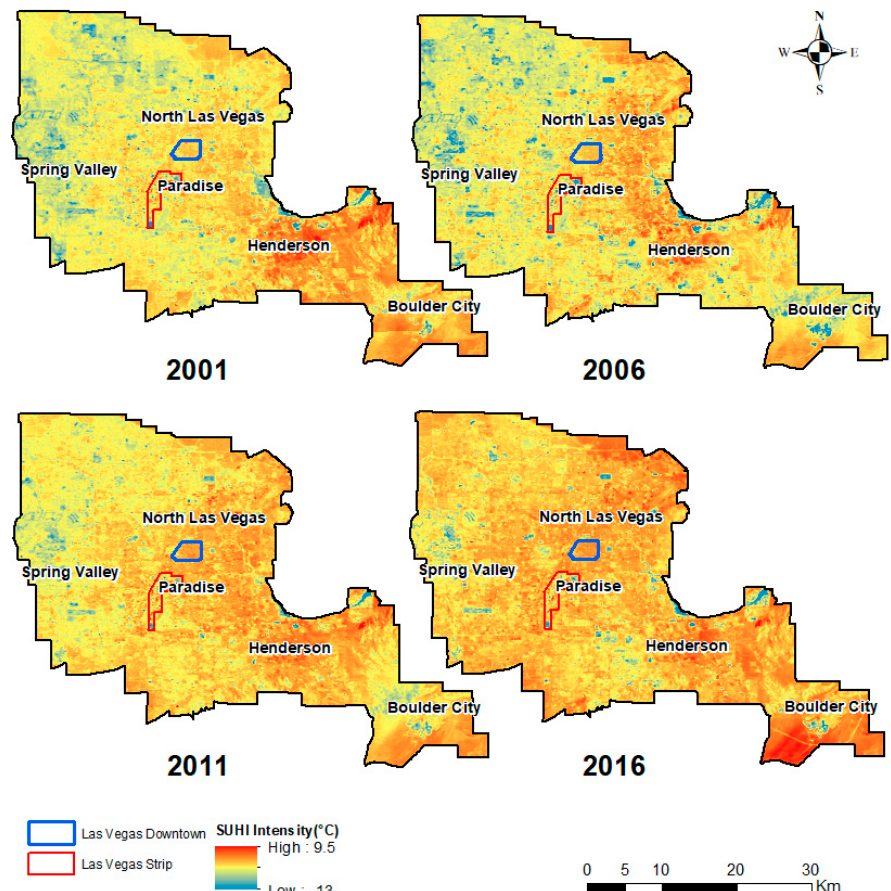
Figure 3. Surface urban heat island intensity (temperature difference between each land surface temperature (LST) pixel in the city and the mean LST of the buffer) over Las Vegas for 2001, 2006, 2011, and 2016.